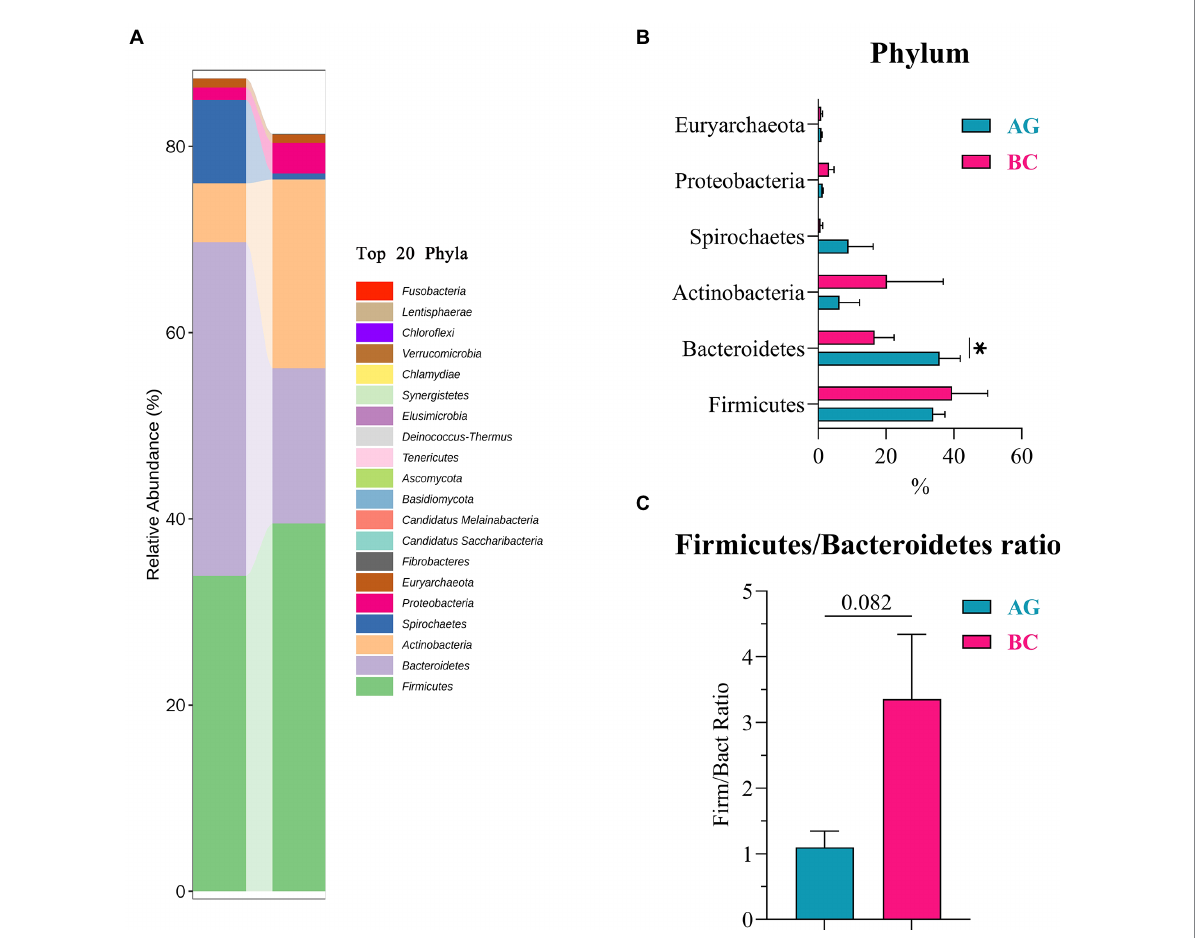
FIGURE 5 The phyla composition and the differentials in the gut microbiota between Xinjiang brown cattle (BC) and Angus cattle (AG; top 20 Phyla). ( n = 5 in each breed). The relative abundance of phyla composition (A) ; The differential phyla in the different relative abundance (B) ; Firmicutes/ Bacteroidetes Ratio (C) . Values were expressed as means ± SEM. * denotes p < 0.05 indicating significant